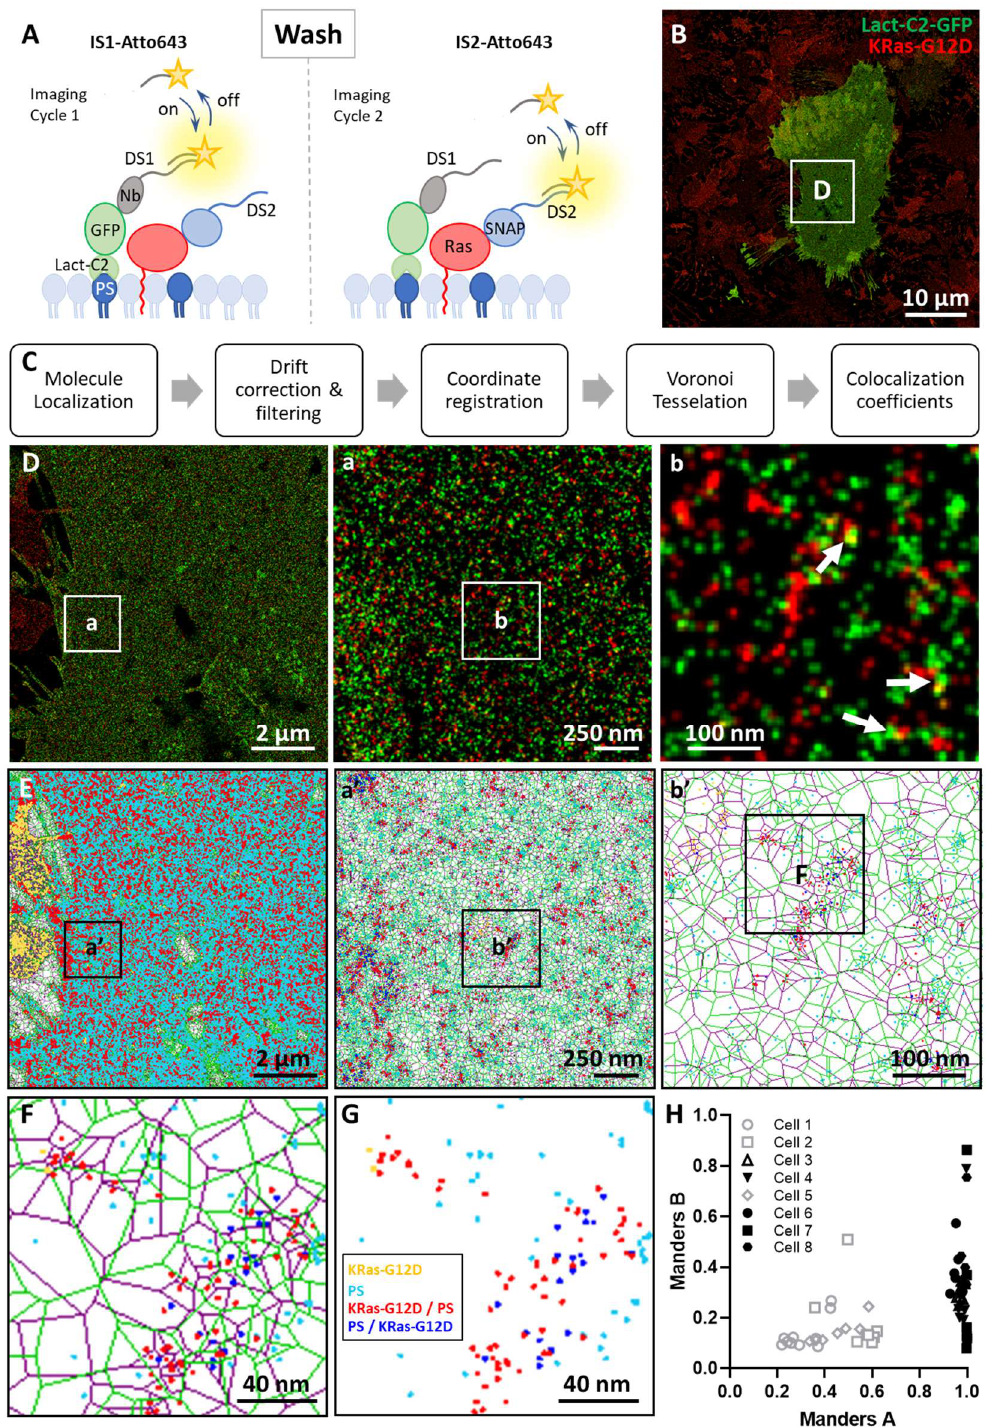
Figure 2. Multiplexed imaging of PS and KRas-G12D using exchange-PAINT and assessment of colocalization with Coloc-Tesseler. ( A ) Schematic of dual-color imaging with fluorescently conjugated imaging strands, each targeting the corresponding docking strand. DS1 conjugated to the GFP-nanobody (Nb-DS1, grey) binds to the transiently transfected PS sensor Lact-C2-GFP (green) and is recognized by IS1-Atto643. DS2 conjugated to the SNAP-substrate reacts with SNAP tag to form a covalent linkage and is recognized by IS2. The two targets are probed sequentially in two imaging cycles with a washing step in between to remove the imager strand used in the previous cycle, allowing the same (bright) fluorophore to be used for imaging both targets. ( B ) Example dual- color DNA-PAINT image of PS (green) and KRas-G12D (red) in U2OS cells. All cells in the field of